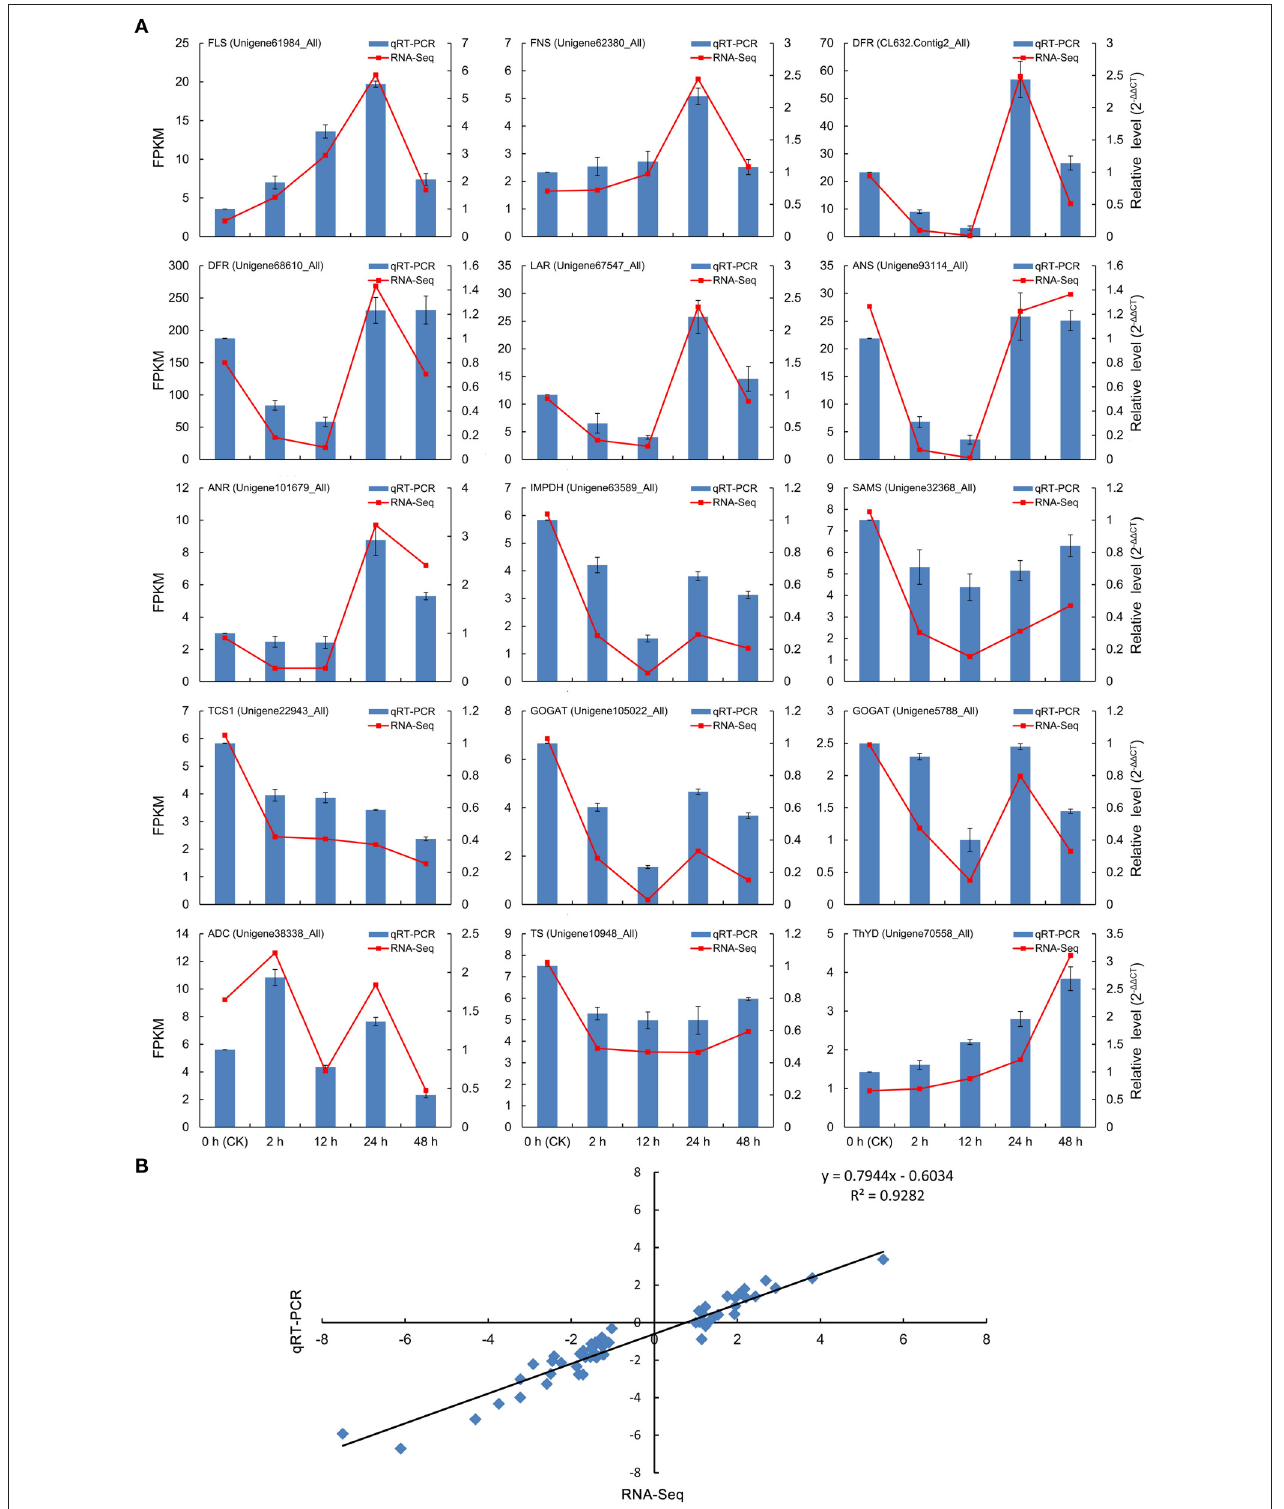
FIGURE 8 | Verification of the relative expression levels of DEGs by qRT-PCR. (A) Expression patterns of 15 DEGs related to the flavonoid, caffeine, and theanine biosynthetic pathways by qRT-PCR (blue bar) and RNA-Seq (red line). (B) Correlation of the expression levels of the 15 DEGs measured by qRT-PCR and